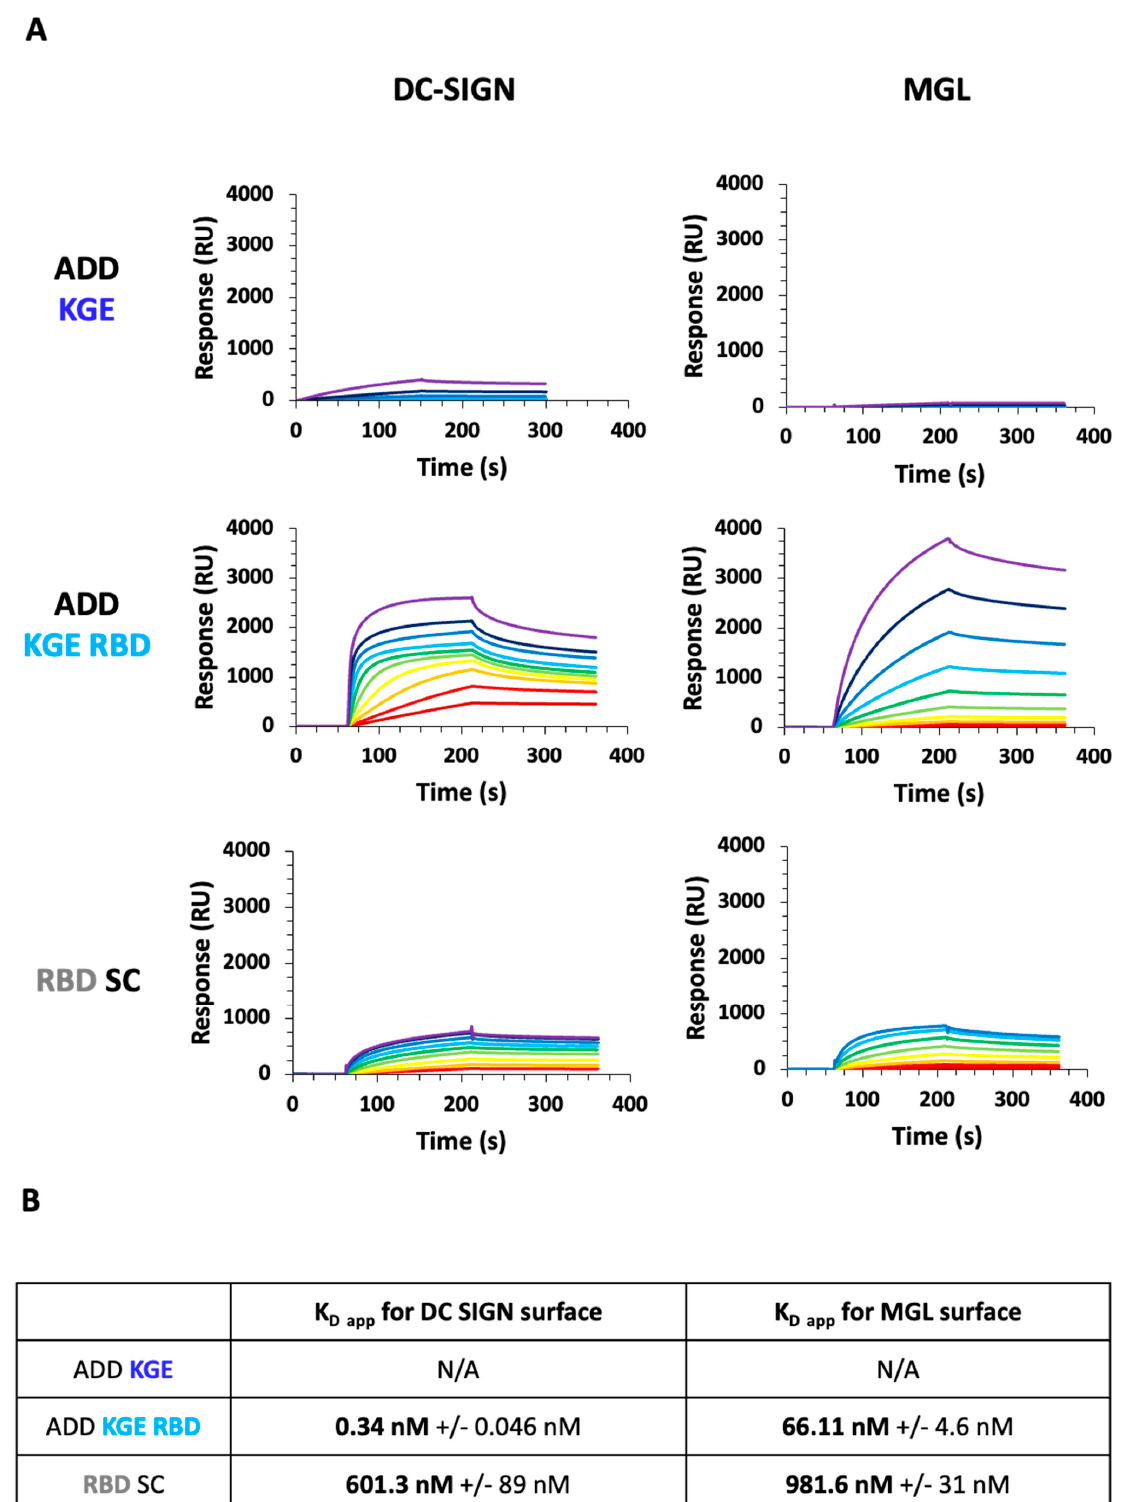
Figure 7. ADD KGE, ADD KGE RBD and RBD-SC binding evaluation on DC-SIGN and MGL receptors by surface plasmon resonance. ( A ) Sensorgrams of the interaction of the ADD-KGE constructs and RBD-SC onto DC-SIGN or MGL oriented surface. For ADD KGE and ADD KGE RBD, injected concentrations range from 136 nM to 0.2 nM by cascade dilution by a factor of 2. For RBD SC, concentration used range from 14.4 µ M down to 56 nM by cascade dilution by 2. ( B ) Table of apparent K D calculated using steady state analysis in the BIAEval